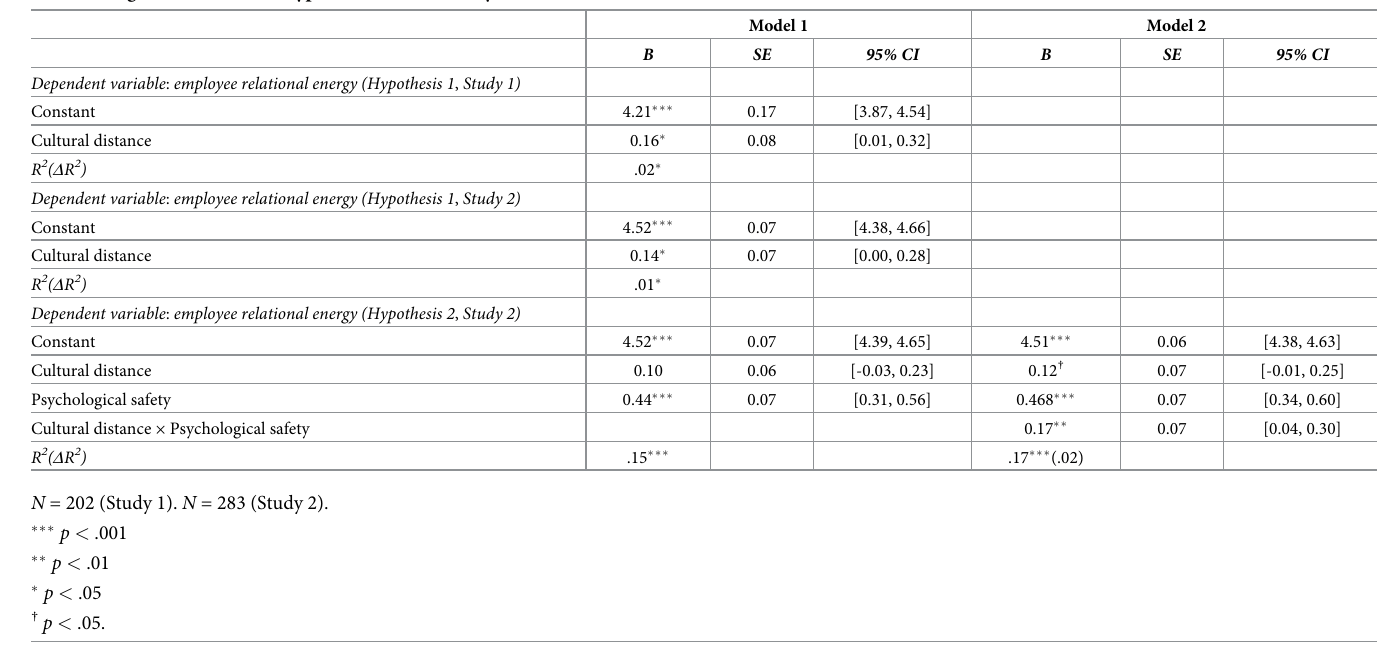
Table 2. Regression results of Hypothesis 1 & 2 in Study 1 &